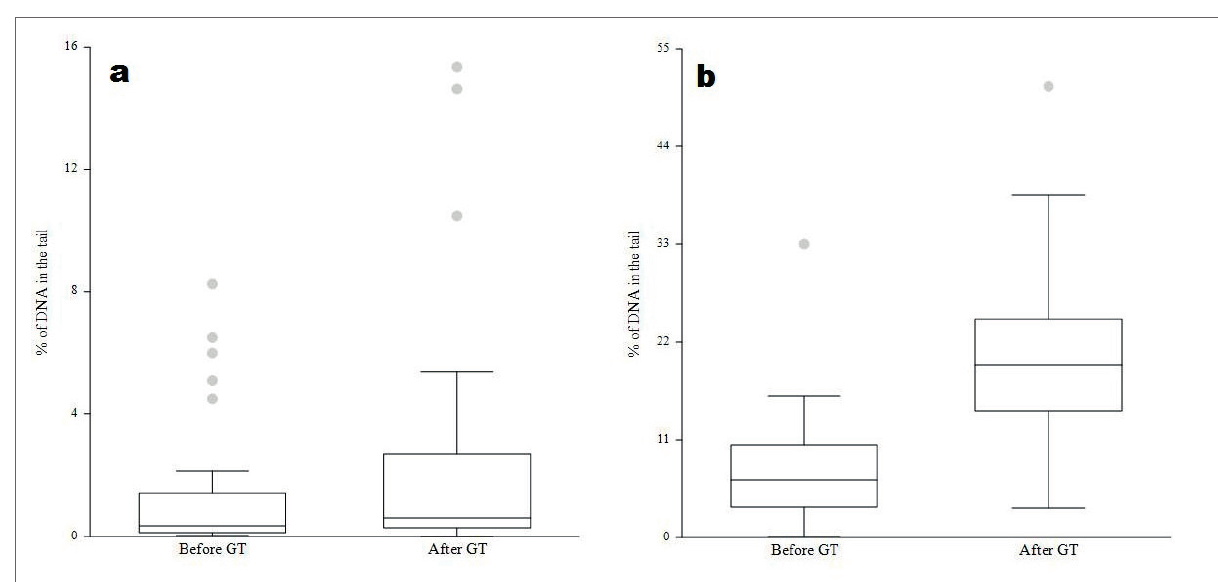
Fig. 1. Comet assay: quantification of DNA breaks (a) DNA-SSBs (alkaline version) and (b) DNA-DSBs (neutral version). The middle of the box: median The lower boundary of the box: 1st quartile (Q1) The upper boundary of the box: 3rd quartile (Q3) The height of the box: inter-quartile range (IQR) The lower whisker boundary: the smallest observation that is greater than or equal to Q1 – 1.5 x IQR The upper whisker boundary: the largest observation that is less than or equal to Q3 + 1.5 x IQR Points outside the whisker boundaries: